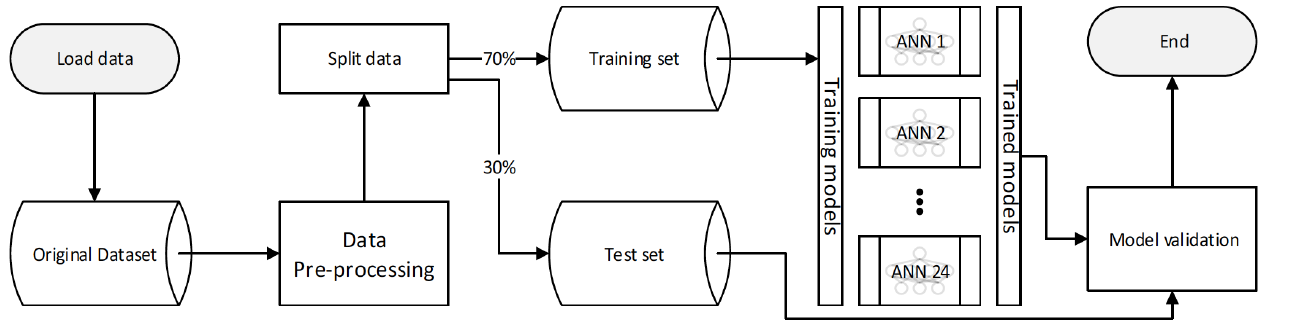
Figure 4. Scheme of the second approach according to the specific models that may compose the target